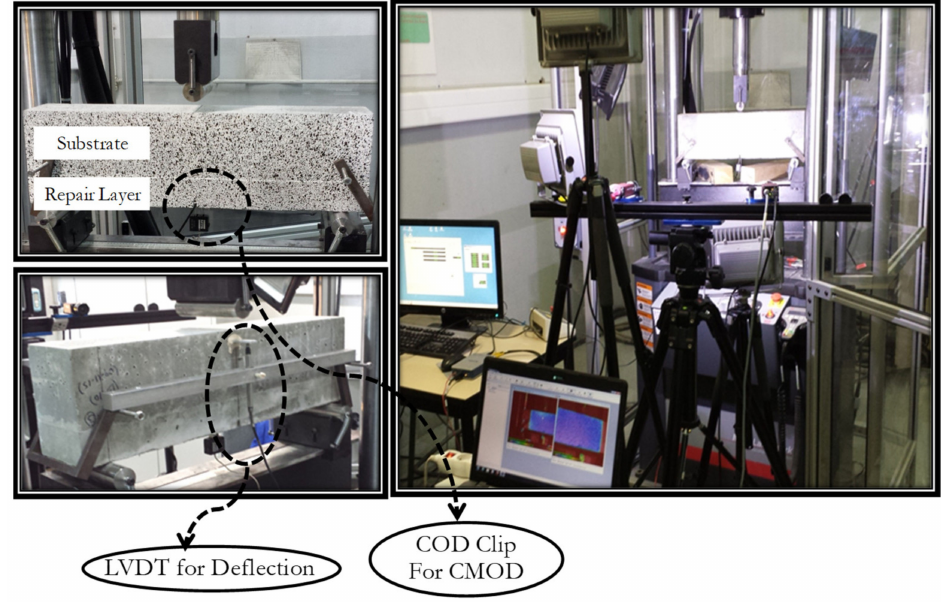
Figure 8. Complete testing layout for three-point bending monotonic test using DIC